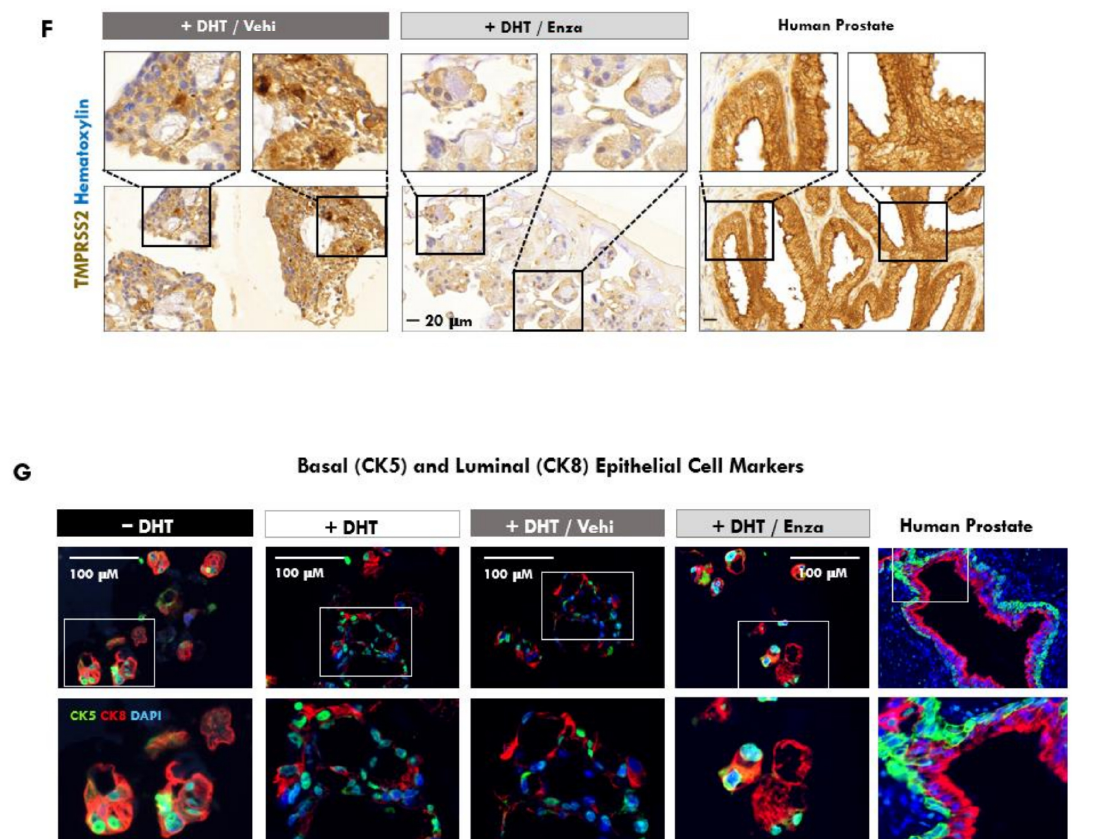
Figure 4. The anti-androgen, enzalutamide, decreased the protein levels of AR and TMPRSS2 in ADT-resistant PDO. ( A ) Quantitative RT-PCR analysis for AR level in PCSD1 3D organoids un- der the four treatment conditions: − DHT, +DHT (1 nM), +DHT/Vehicle (1 nM/0.1% DMSO) and +DHT/enzalutamide (1 nM/10 µ M). Human beta actin was used as the internal control, reference gene (delta delta C t target/reference). ( B ) IHC analysis of AR expression in PCSD1 3D organoids. Represen- tative digital microscope images are shown of AR IHC staining performed on 4% paraformaldehyde fixed, paraffin embedded 5 µ m sections from four culture conditions. Human prostate tissue was used as a positive control. ( C ) Quantitative RT-PCR analysis for PSA level in PCSD1 3D organoids. ( D ) Quantitative RT-PCR analysis for PSMA level in PCSD1 3D organoids under the four treatment conditions. Graphs represent one experiment performed in duplicate. ( E ) Immuno-histochemical (IHC) analysis of PSA expression in PCSD1 3D organoids. Red arrows point to PSA positive staining. ( F ) IHC analysis of TMPRSS2 expression in PCSD1 3D organoids. Representative digital microscope images are shown of ( B , E , F ) IHC staining performed on 4% paraformaldehyde fixed, paraffin em- bedded 5 µ m sections from four culture conditions. Data represent the mean from four independent ( n = 3) experiments performed in triplicate. ( G ) Confocal FV1000 images of IFC performed on PCSD1 3D organoids and normal human prostate cancer control tissue to visualize the prostate epithelial cell markers: cytokeratin 8 (CK8), a luminal epithelial cell protein, and cytokeratin 5 (CK5), a basal epithelial cell protein along with DAPI nuclear stain. Top five panels: PCSD1 3D organoids and patient prostate cancer tissue showed CK8 protein (red), and CK5 protein (green). DAPI stained the nuclei (blue). Inset (white square) shows further magnified image of organoids in panels 1–4 and normal prostate in panel 5 with CK8 (red) and CK5 (green) immunostaining. In the PCSD1 organoids, immunofluorescent cytochemical (IFC) analysis of CK5 and CK8 revealed heterogeneous expression patterns. Confocal microscope imaging of the control tissue, normal human prostate, showed the expected pattern of CK5 + basal cells and CK8 + luminal cells in glandular